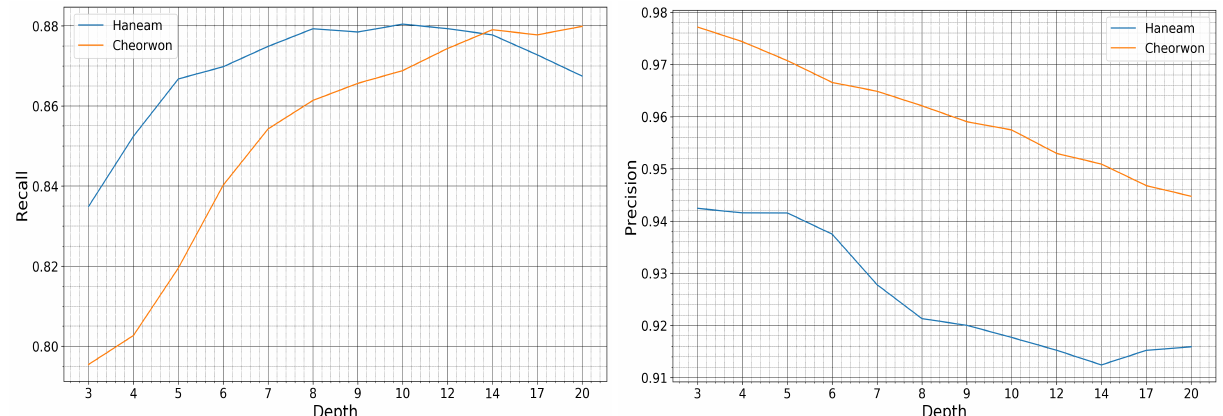
Figure 12. Recall and Precision of the Haenam and Cheorwon sites, for models trained with pseudo-labels of the Seosan- Dangjin site, with 50 trees, various depths.